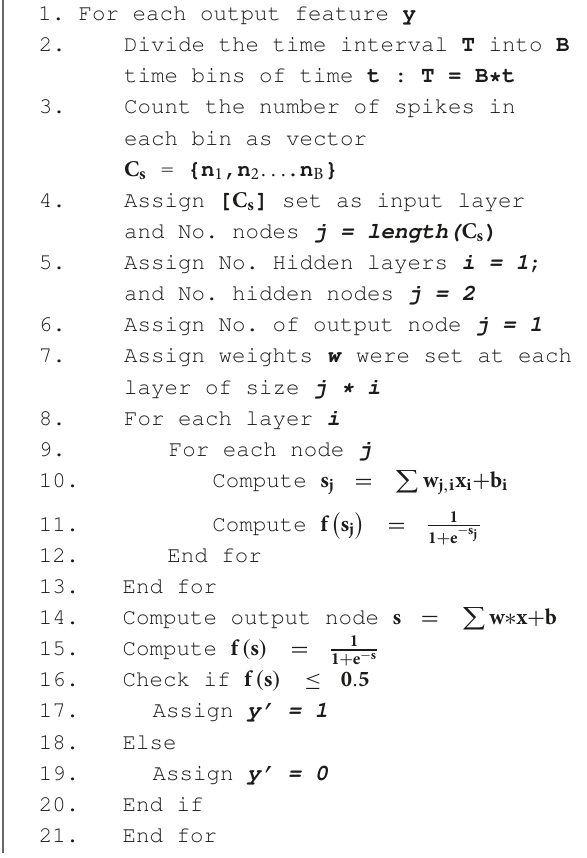
Algorithm 3: Decoding using a rate coded convoluted network.